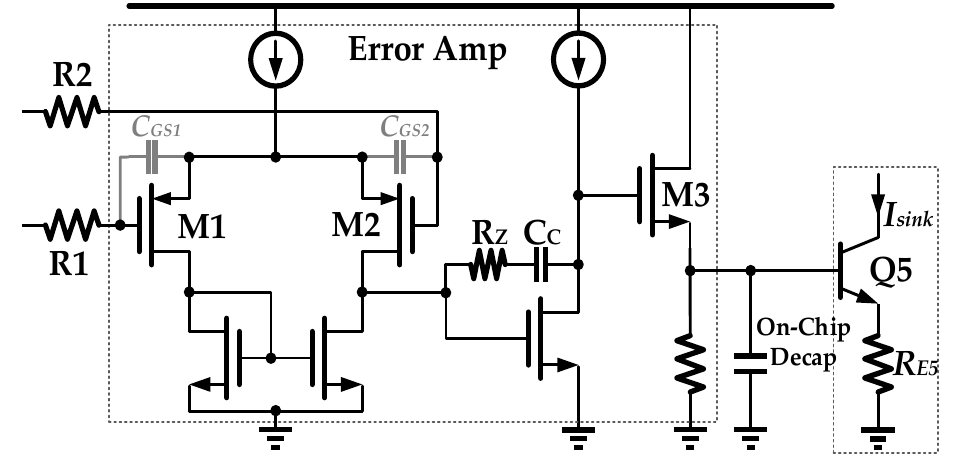
Figure 14. A schematic of the DC offset cancellation (DCOC) circuit.